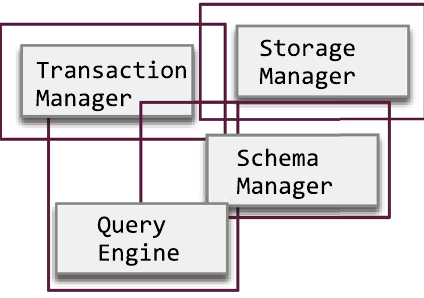
Fig. 4 Classic DBMS functions